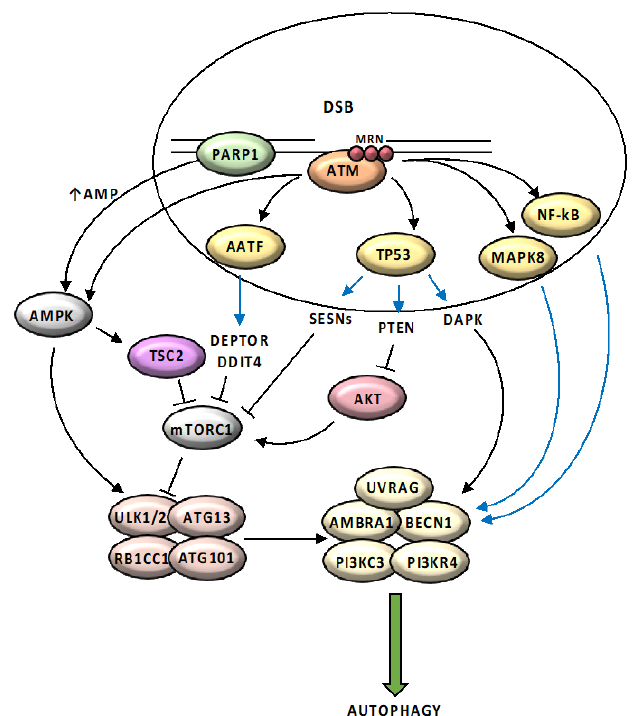
Figure 3. Schematic representation of main pathways regulating the DDR-mediated autophagic response. ATM is activated in response to DNA damage by the MRN complex and initiates a pathway that results in activation of AMPK and its target TSC2 (TSC complex subunit 2), which removes the inhibitory e ff ect of MTORC1 on autophagy, promoting ULK1-dependent autophagosome formation. ATM directly phosphorylates and stabilizes TP53, which activates the expression of several regulators of the autophagic pathway including SESNs (Sestrin family genes), DAPK (death-associated protein kinase 1) and PTEN (phosphatase and tensin homolog). ATM contributes to the activation of AATF (apoptosis antagonizing transcription factor) and leads to increased transcription of two mTOR inhibitors, DDIT4 (DNA damage inducible transcript 4) and DEPTOR (DEP domain containing MTOR interacting protein). DNA damage response activates MAPK8 (mitogen-activated protein kinase 8) and NF κ B (nuclear factor kappa-light-chain-enhancer of activated B cells) pathways, that induce expression of several autophagy related genes, including BECN1 . PARP1 activation in response to DNA damage causes reduction in NAD + (nicotinamide adenine dinucleotide) and ATP (adenosine triphosphate) pool depletion; elevated AMP (adenosine monophosphate) levels are sensed by AMPK, leading to its activation and induction of autophagy. Black arrows ( ↑ ) and perpendicular lines ( ⊥ ) indicate activation and repression, respectively. Blue arrows indicate transcriptional